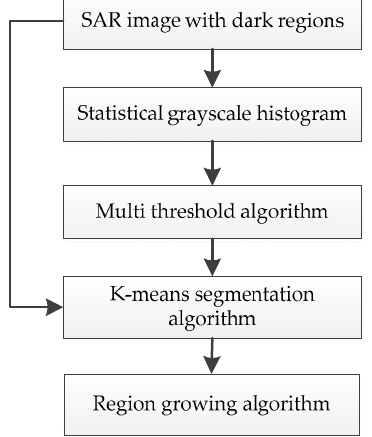
Figure 9. Flowchart of dark region segmentation.